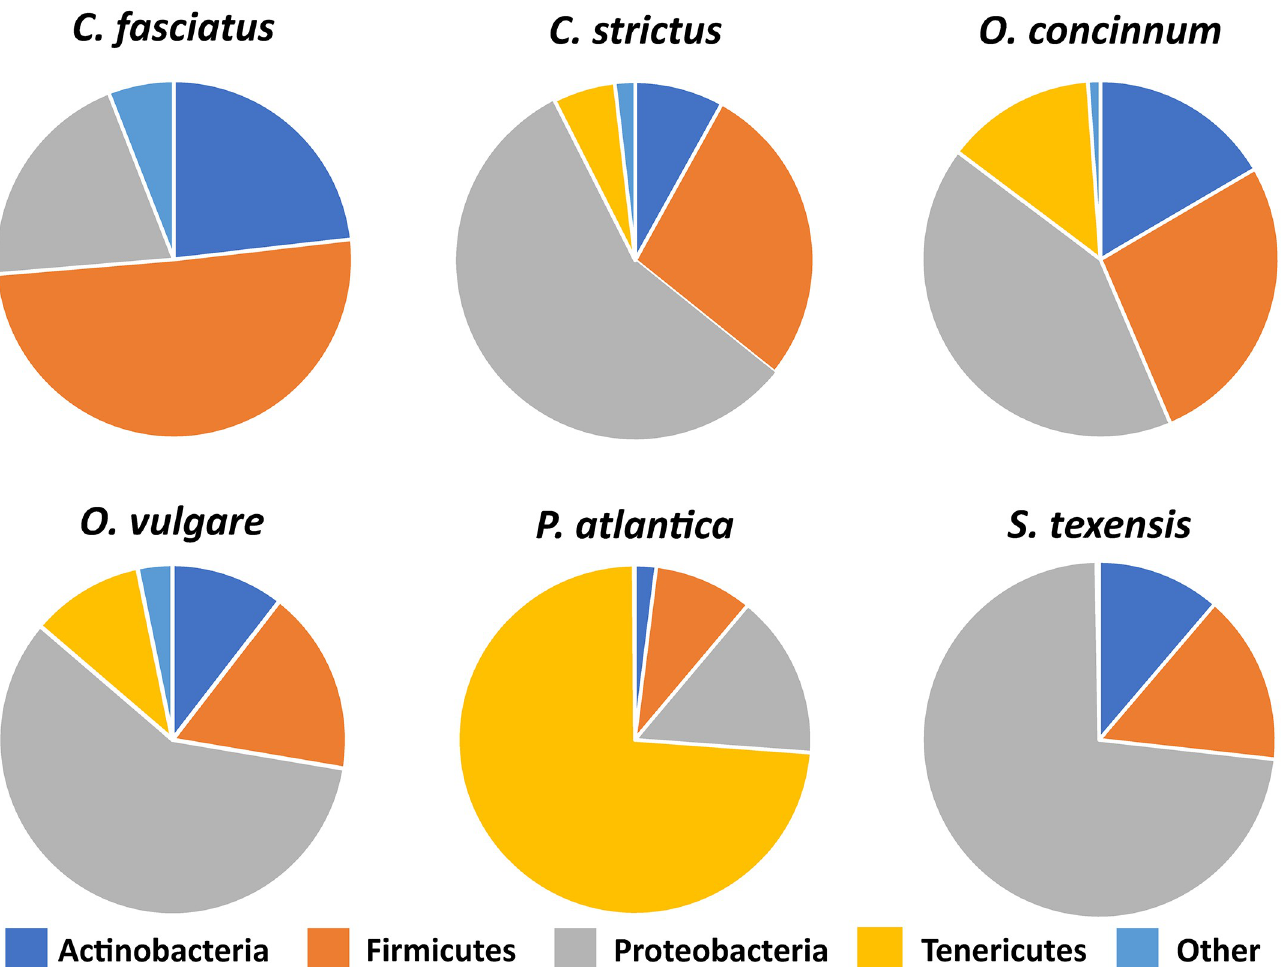
Fig 1. Mean relative abundance of bacterial phyla in the gut of six grasshopper species. Bacterial phyla, predicted from the amplified V3-V4 region of the bacterial 16s rRNA gene, were shown if they were present at > 1.5% relative abundance in each grasshopper species. Phyla that were present at < 1.5% relative abundance in each grasshopper species are grouped together as “Other.” For specific values, see S2 File.